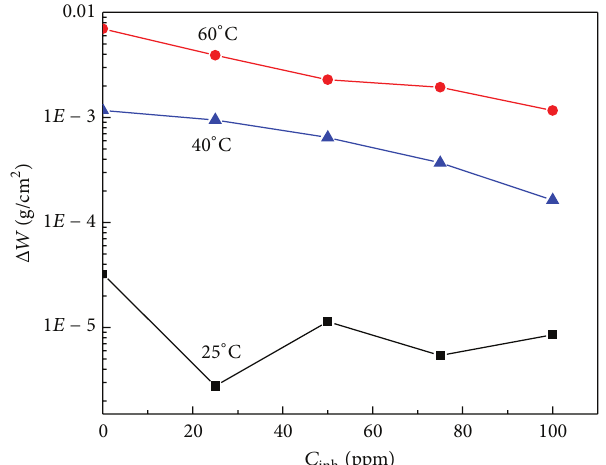
Figure 1: Effect of Opuntia ficus-indica concentration and tempera- ture on the weight loss for carbon steel in 1M HCl.